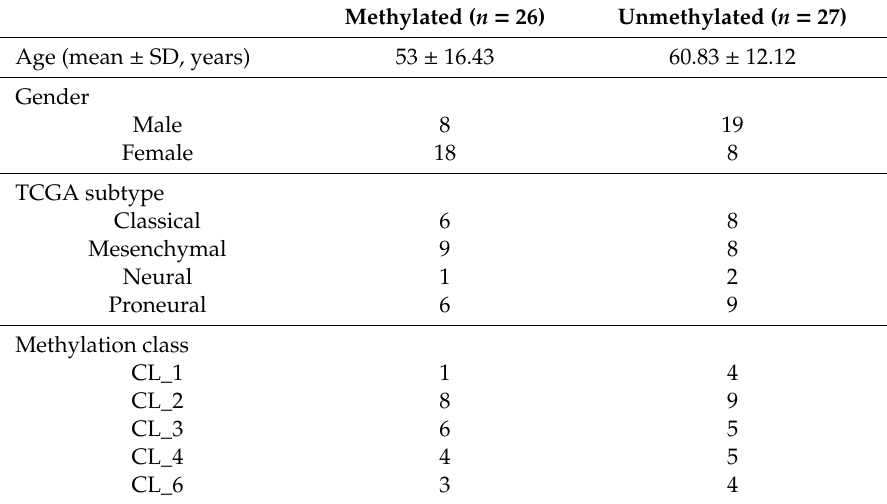
Table 1. Patient characteristics ( n =